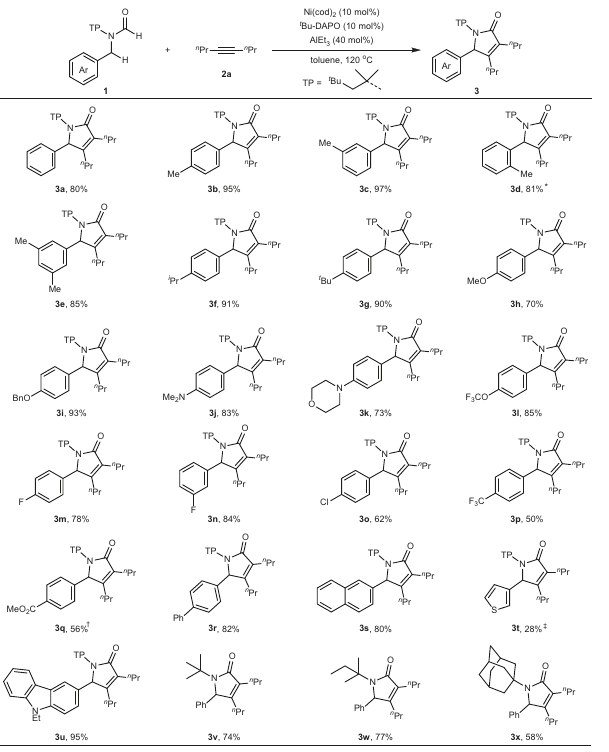
Fig. 2 | Scope of formamides. Reaction conditions: 1 (0.2mmol), 2a (0.6mmol), toluene(1.0mL)underN 2 for2h;yieldofisolatedproducts.*AlEt 3 (60mol%). † AlEt 3 (80mol%), 4h. ‡ AlEt 3 (100mol%). n Pr= n -propyl. t Bu= tert -butyl.